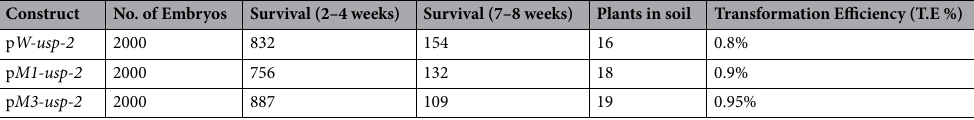
Table 1. Transformation efficiency of Gossypium